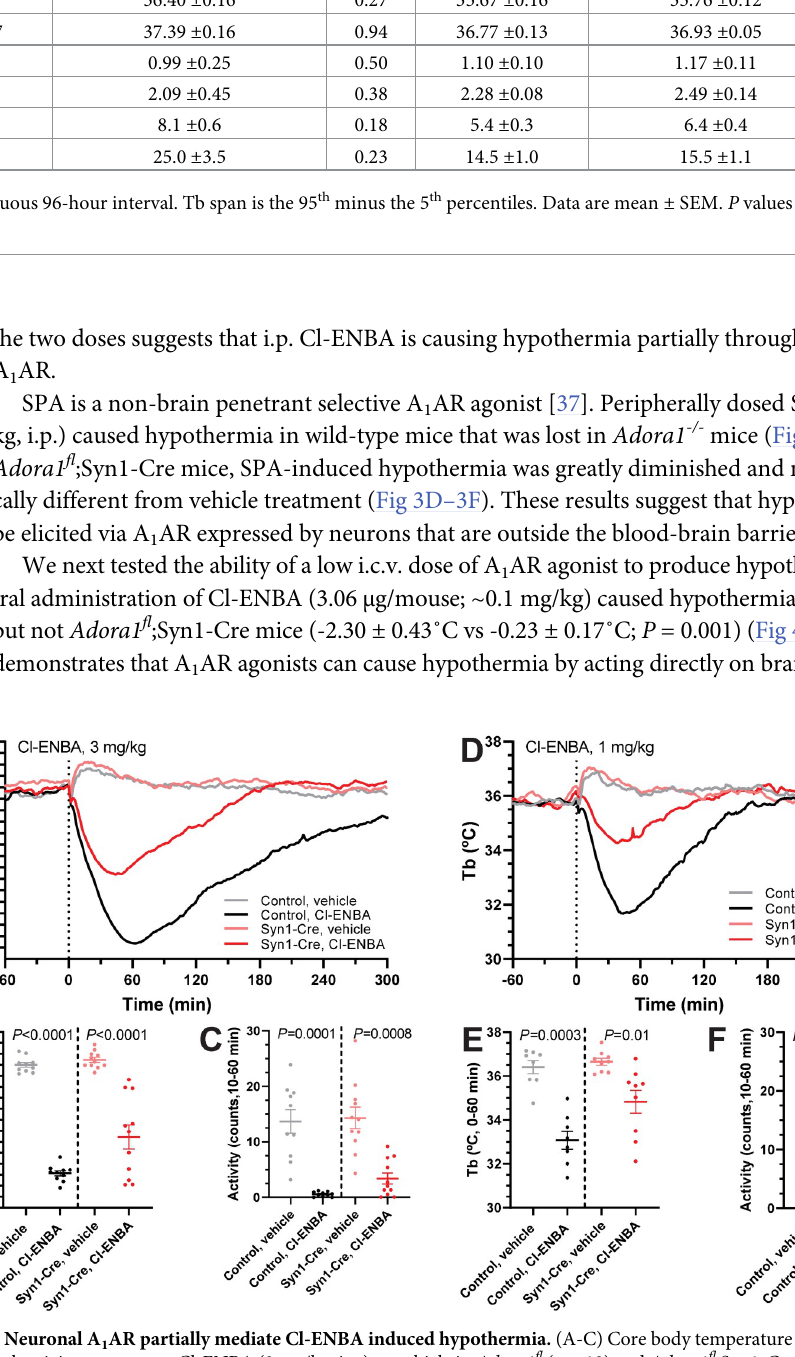
Table 1. Deletion of neuronal A 1 AR has no effect on baseline body temperature or physical activity.